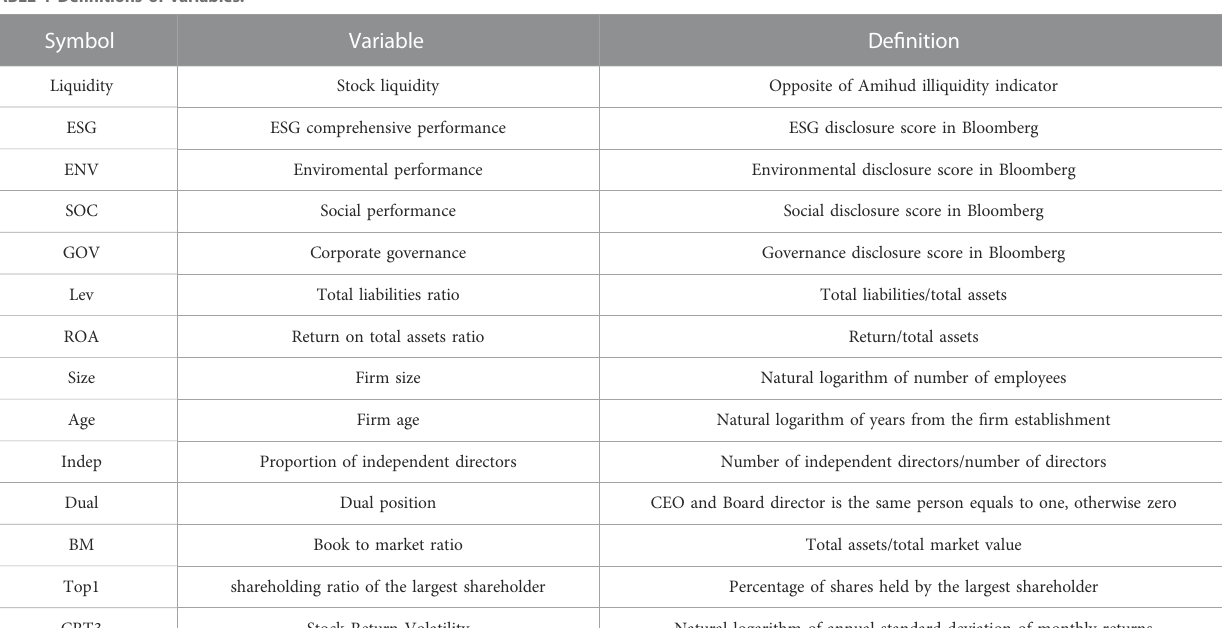
TABLE 1 De fi nitions of